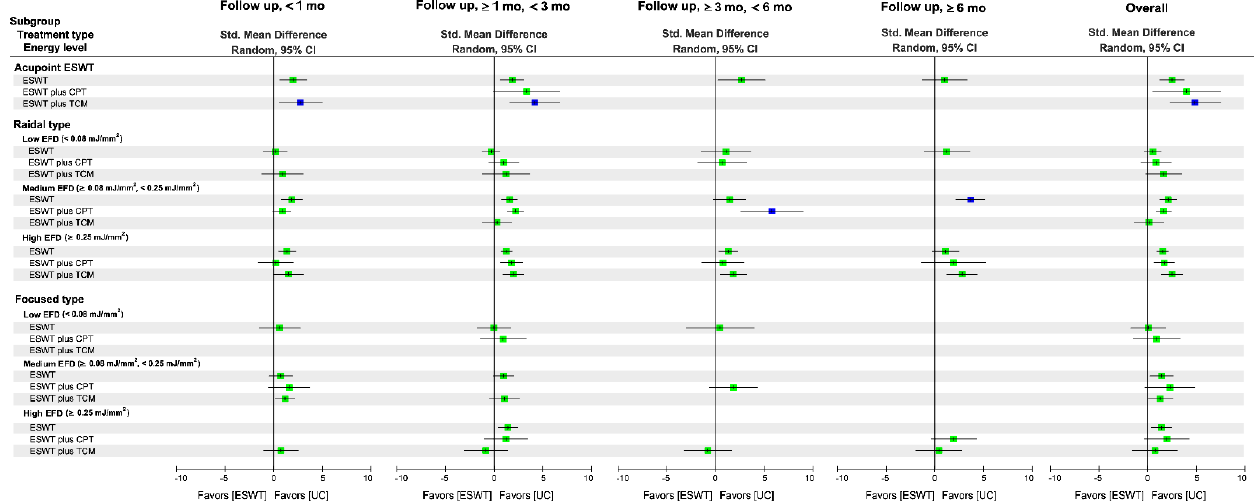
Figure 4. Relative effects among treatment regimens of ESWT on pain reduction at each timeframe and during an overall follow-up duration. The square point in each timeframe and for the overall duration presents the network combined effect (SMD) on changes in pain score relative to UC, and the horizontal line denotes a corresponded 95% CI. The highest rank of probability among all treatments in the same timeframe is denoted by a blue point. 95% CI = 95% confidence interval; mo, month; ESWT, extracorporeal shockwave therapy; EFD, energy flux density; CPT, conventional physical therapy; SMD, standard mean difference; TCM, traditional Chinese medicine; UC, usual care.